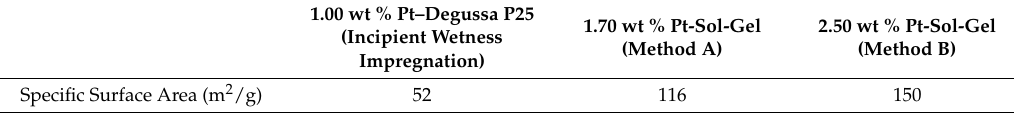
Table 2. Specific surface areas for the prepared photocatalysts.